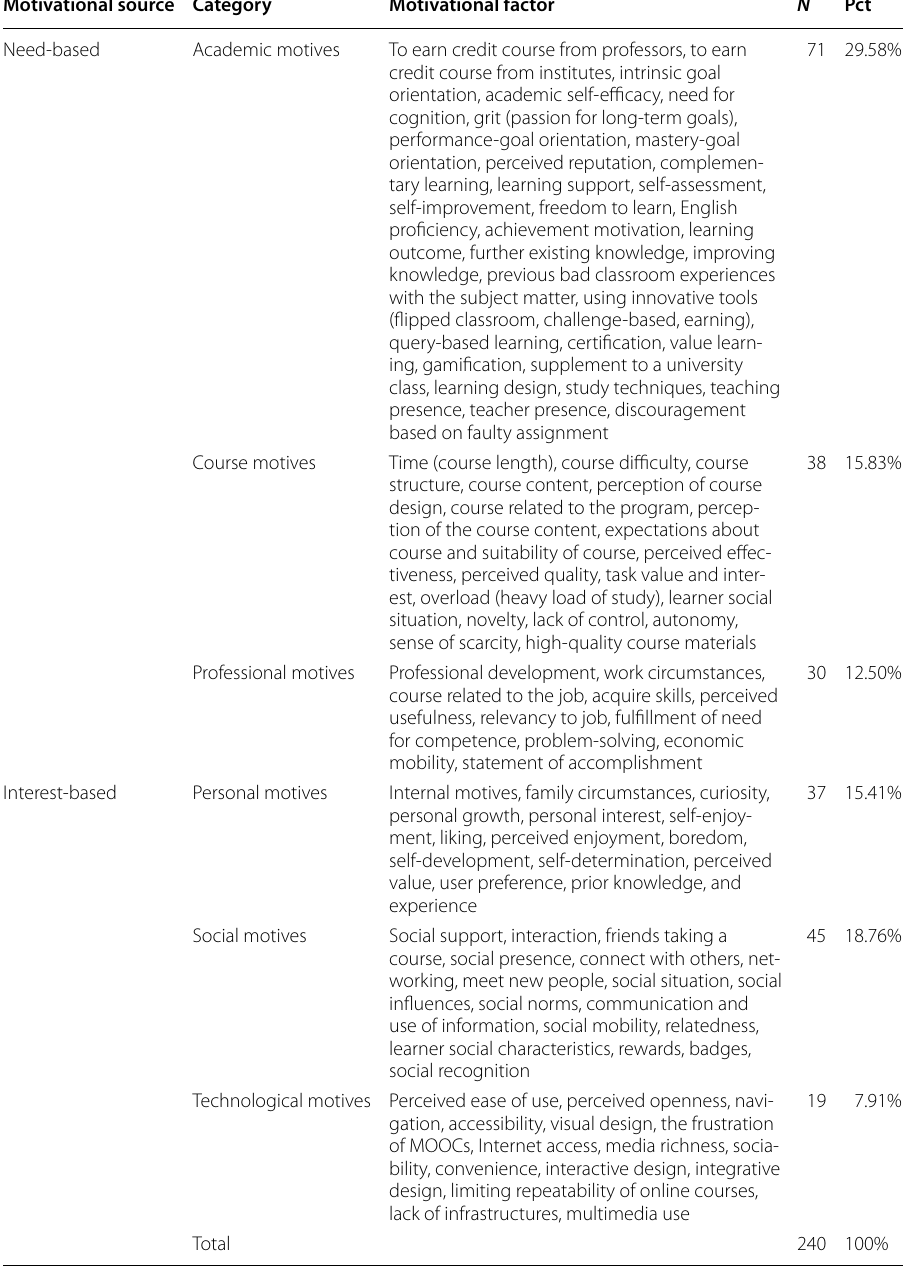
Table 2 Detailed information concerning the main motivational factors Motivational source